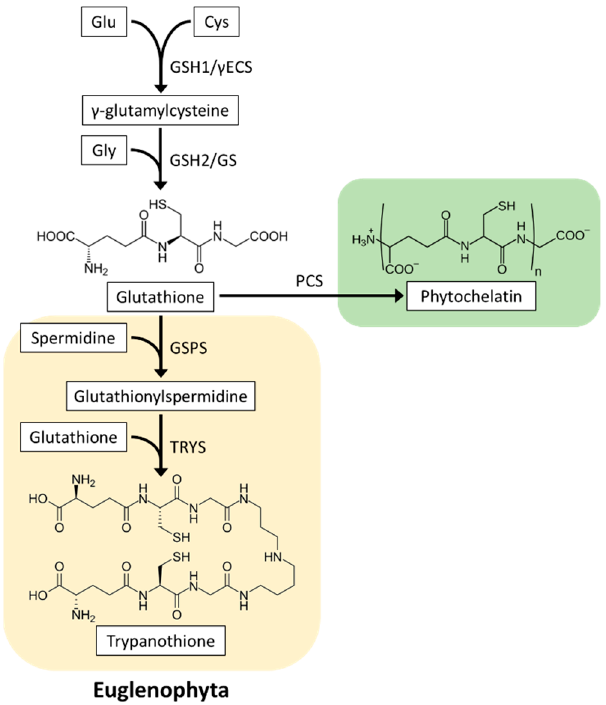
Figure 4. Structure and biosynthesis of glutathione, phytochelatins, and trypanothione in microalgae. Glutathione biosynthesis is conserved in all biological kingdoms. Phytochelatin biosynthesis occurs in most microalgae, whereas among photosynthetic organisms, trypanothione is detected only in Euglenophyta. GSH1/ γ ECS, γ -glutamylcysteine synthetase; GSH2/GS, glutathione synthetase; PCS, phytochelatin synthase; GSPS, glutathionylspermidine synthetase; TRYS, trypanothione synthetase.